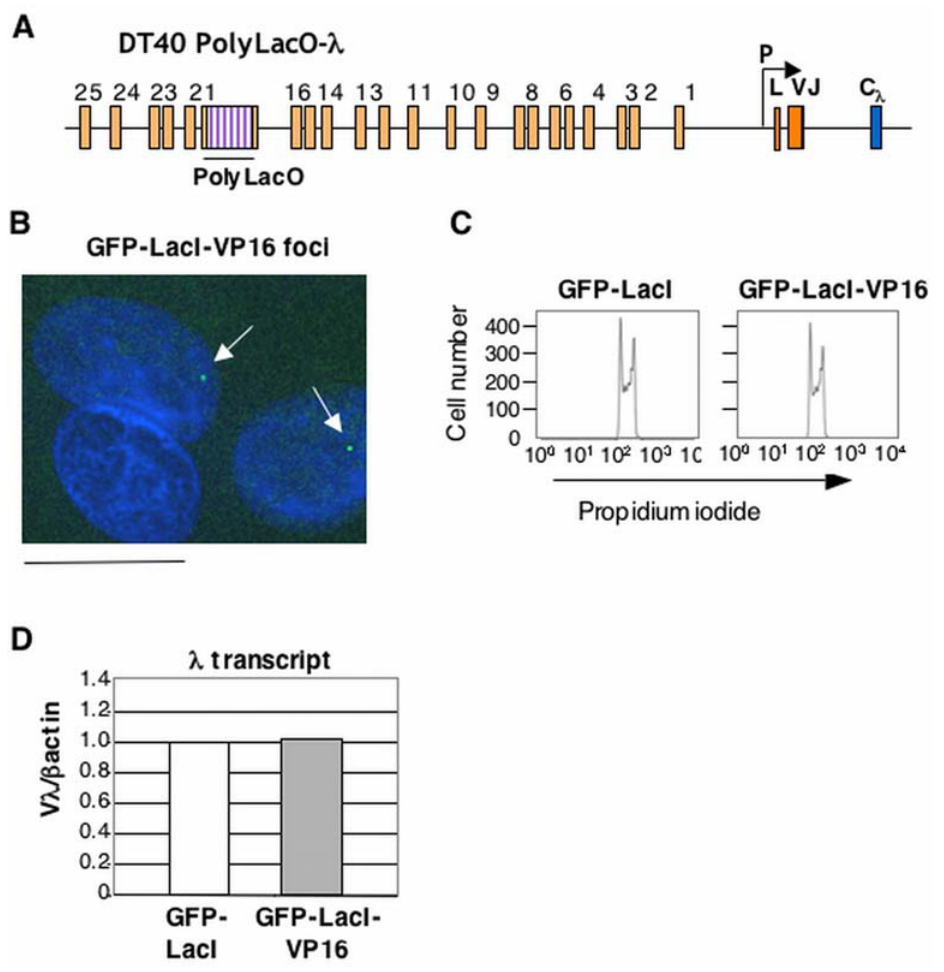
Figure 1. Tethering of GFP-LacI-VP16 to the y V l Array in DT40 PolyLacO- l R. (A) Schematic diagram of the rearranged chicken Ig l locus in DT40, with polymerized lactose operator (PolyLacO) inserted between y V l 17–20. Promoter, P; leader, L; rearranged variable region, V l –J l ; constant region, C l . (B) Fluorescent image of DT40 PolyLacO- l GFP-LacI-VP16 transfectants. Nuclei were counterstained with DAPI (blue). Arrows indicate GFP- LacI-VP16 bound to Ig l . Bar, 15 m m. (C) Cell cycle profiles of DT40 PolyLacO- l GFP-LacI and DT40 PolyLacO- l GFP-LacI-VP16 transfectants. (D) Quantitation of RT-PCR comparison of V l transcript levels in DT40 PolyLacO- l GFP-LacI and DT40 PolyLacO- l GFP-LacI-VP16 transfectants. Values represent the average of at least 2 amplifications that were normalized to the average value for DT40 PolyLacO- l GFP-LacI.